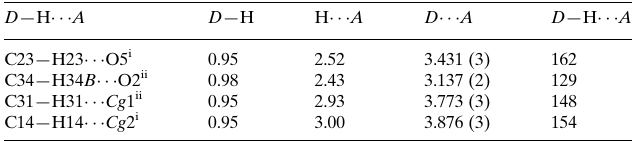
Hydrogen-bond geometry (A˚ , (cid:2) ). Cg 1 and Cg 2 are the centroids of benzene rings C2–C7 and C19–C24,